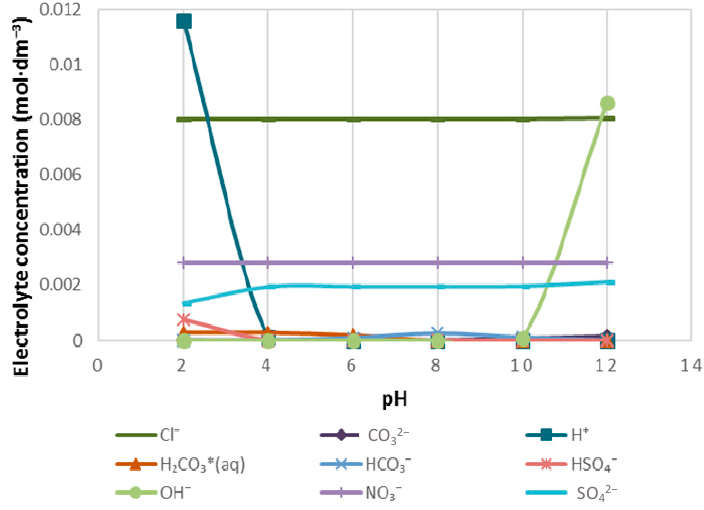
− , CO − and SO 2 − , NO 3 3